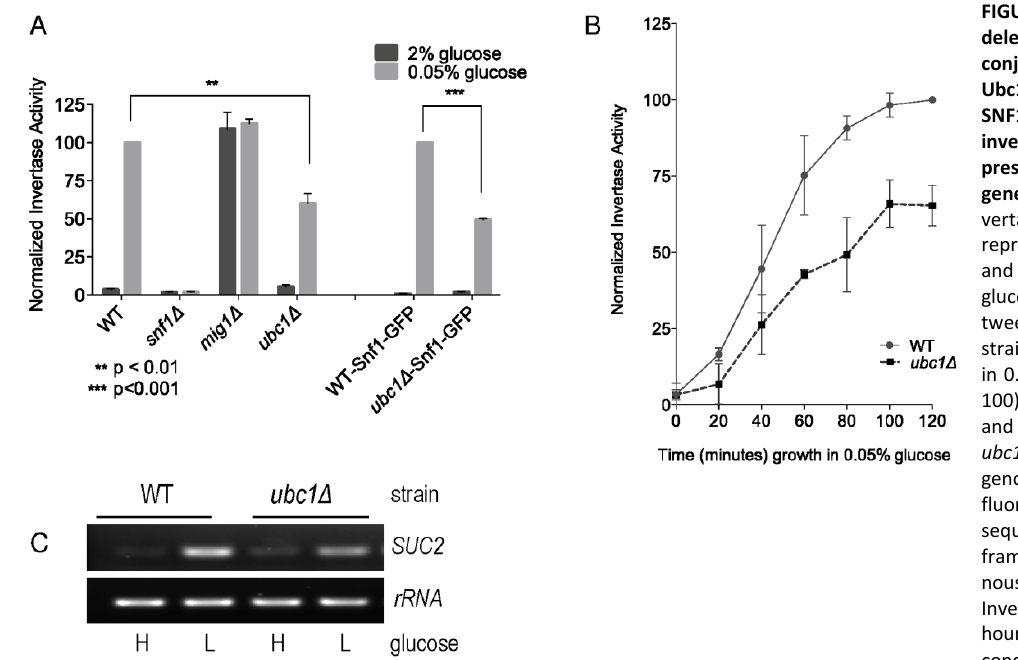
FIGURE 1: Yeast strains deleted for the ubiquitin conjugating enzyme, Ubc1, are impaired for SNF1 kinase-dependent invertase activity ex- pressed from the SUC2 gene. Comparison of in- vertase activity under repressive (2% glucose)